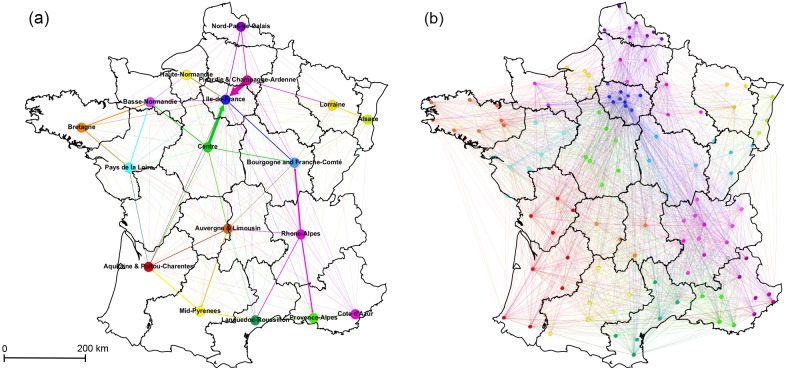
The intercommunity networks of patient transfers.(a) The intercommunity network from the 18 detected general patient network Greedy-based communities named based on the French metropolitan regions they encompass. Edge size and color indicate the source community and number of patients discharged. (b) The intercommunity network from 113 Map Equation communities detected in the general network. The nodes of the networks represent the geographical center of hospitals within the shared community.